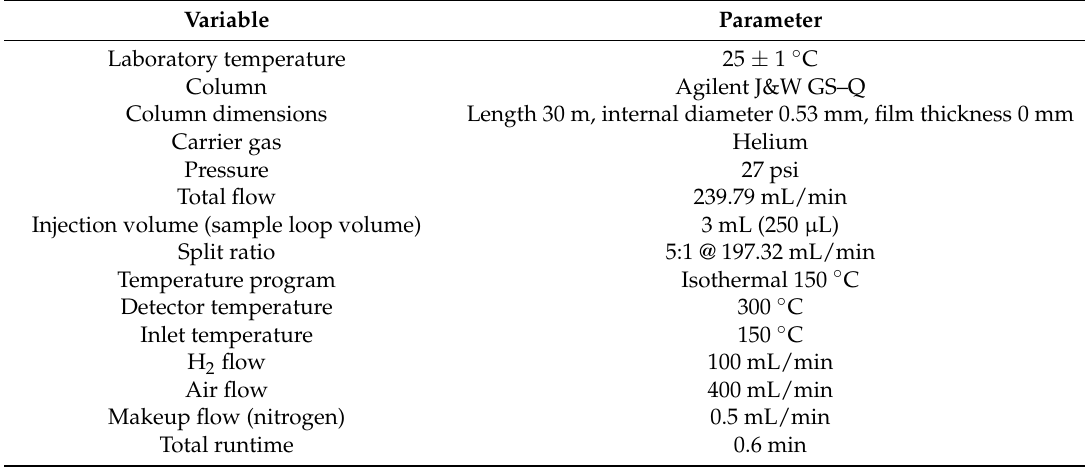
Table 2. Instrument and conditions under which the proposed method for quantifying ethanedinitrile in air was